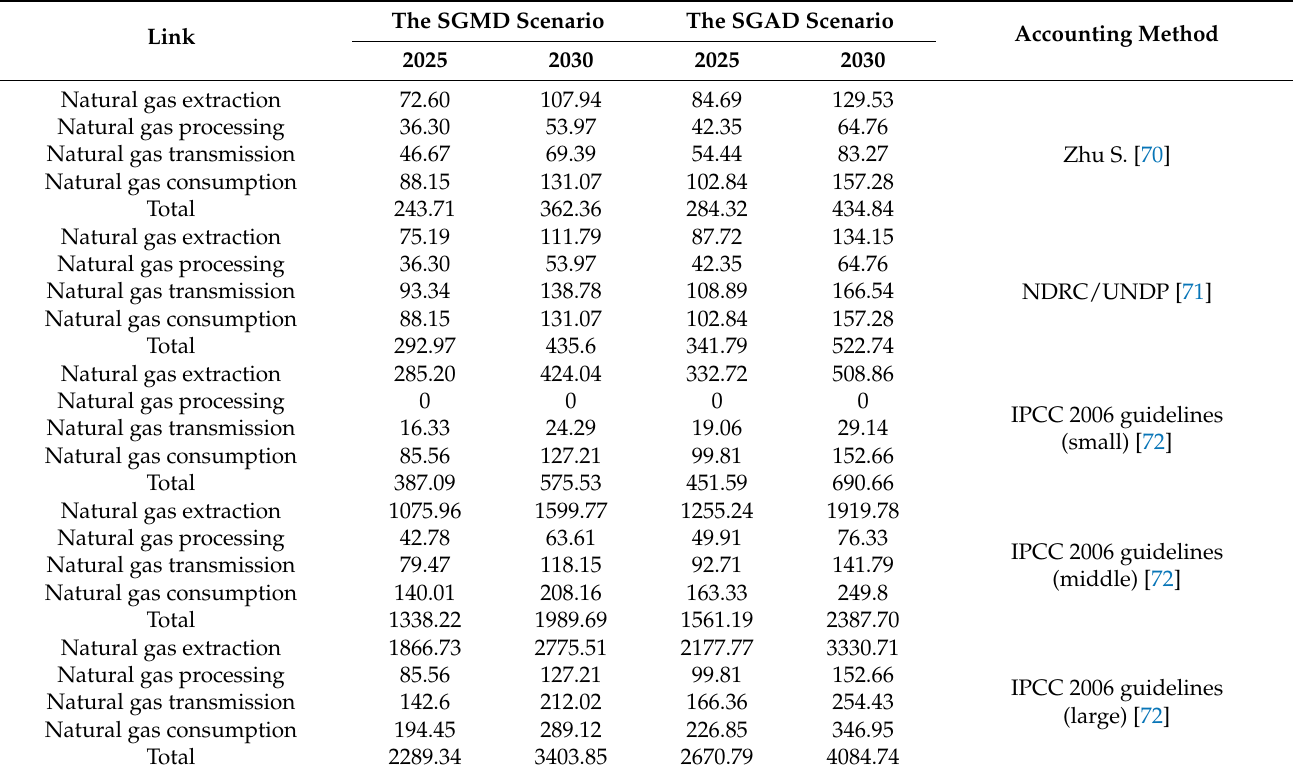
Table 4. Methane emission in each link